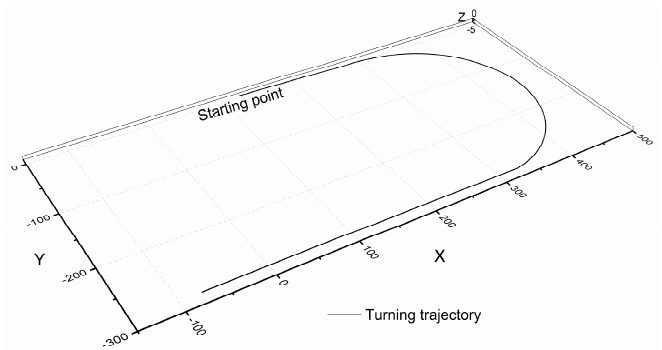
Figure 13. 3D plot of coordinated turn simulation by NMM under Configuration WDH.